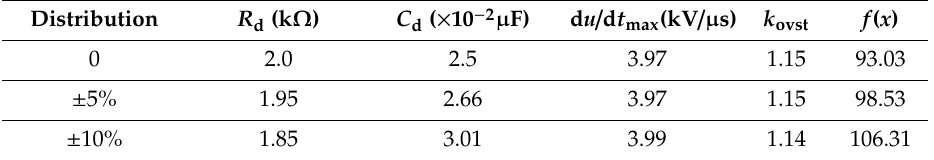
Table 5. Comparisons of Optimized Parameters Considering Di ff erent Q rr Distribution Ranges.